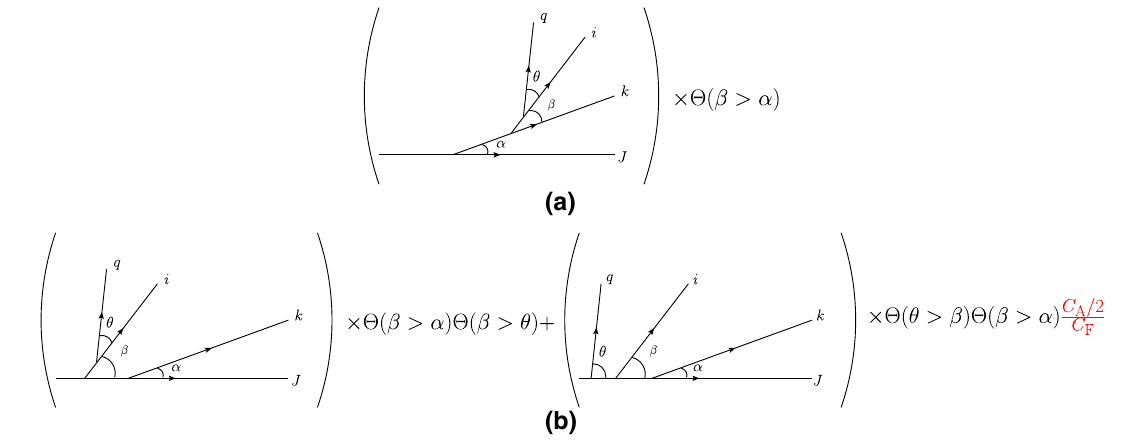
Fig. 6 A second possible ordering of angles that also leads to an incorrect colour